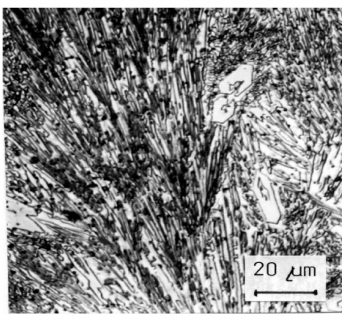
Figure 10. Detail of fine-grain structure of cladding E 518 B.